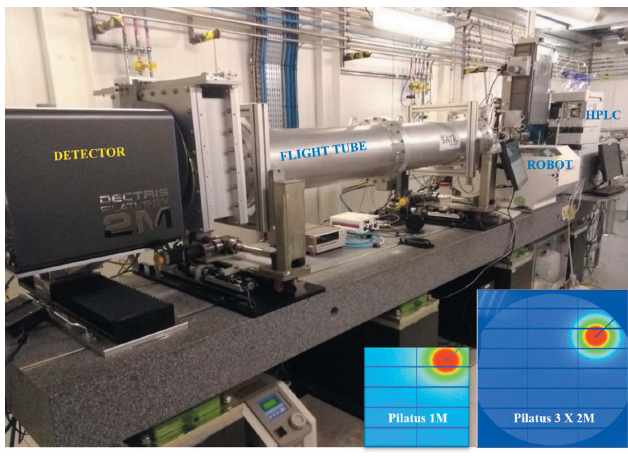
Figure 2 Experimental hutch of BM29 with new large-area detector Pilatus3 X 2M. Inset: comparison of images from Pilatus 1M and Pilatus3 X 2M.